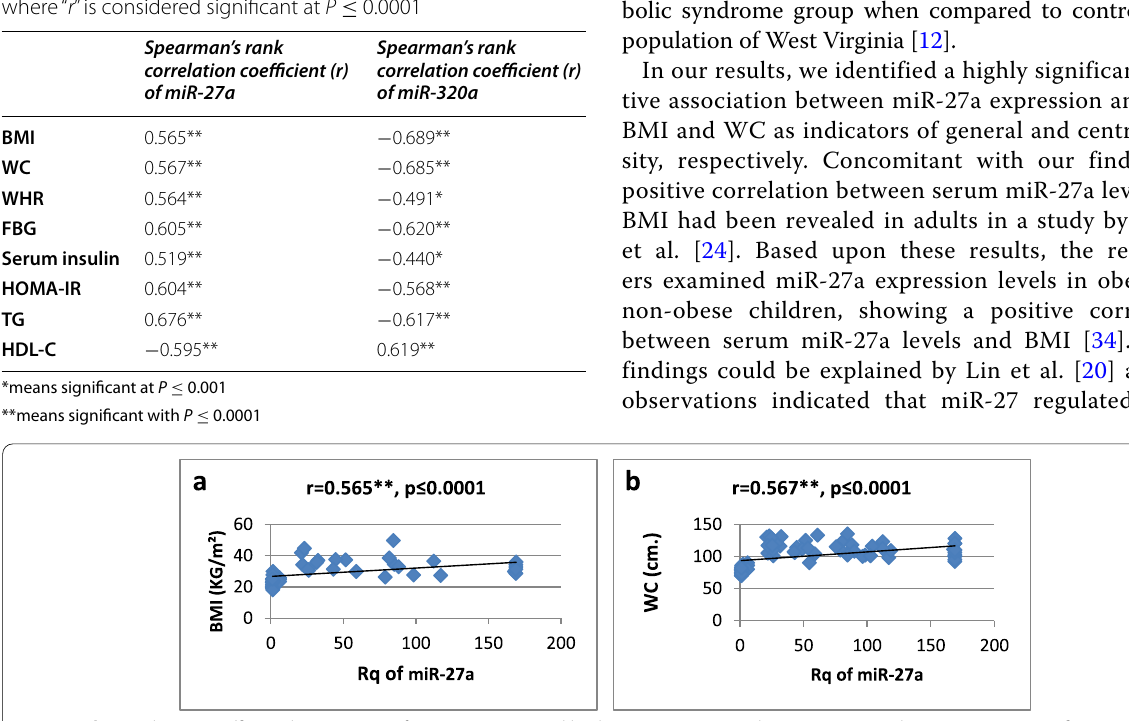
0.565) and WC ( r 0.567), where “**” means significant at = =